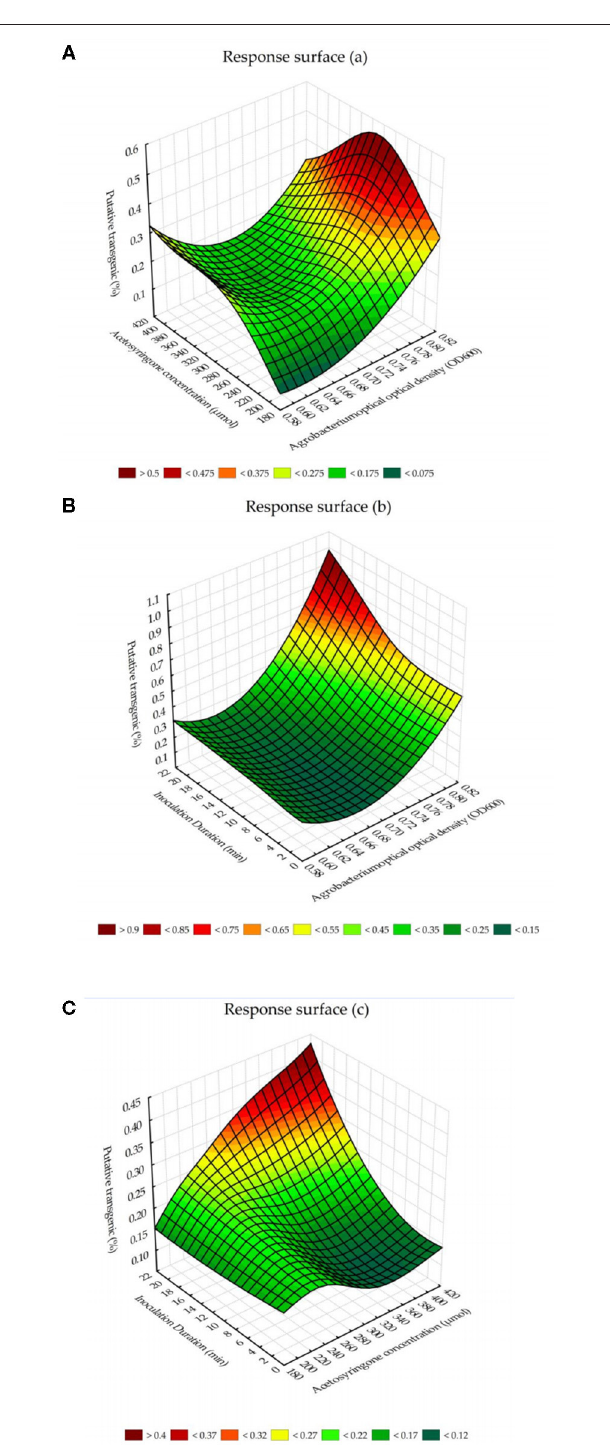
FIGURE 3 | The response surface for the interaction effects of Agrobacterium -mediated gene transformation parameters on putative transgenic tobacco plants. (A) The interaction effects of Agrobacterium cell densities and acetosyringone concentrations on the percentage of putative transgenic tobacco plants. (B) The interaction effects of Agrobacterium cell densities and inoculation durations on the percentage of putative transgenic